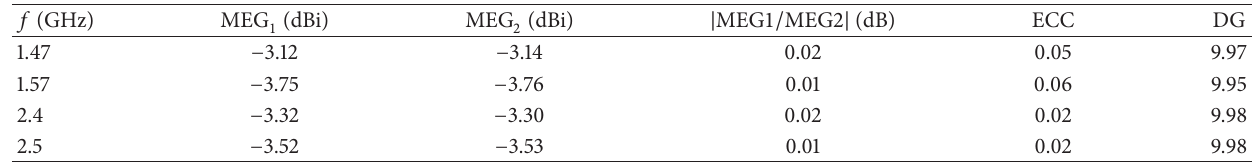
Table 3: Diversity performance of the proposed